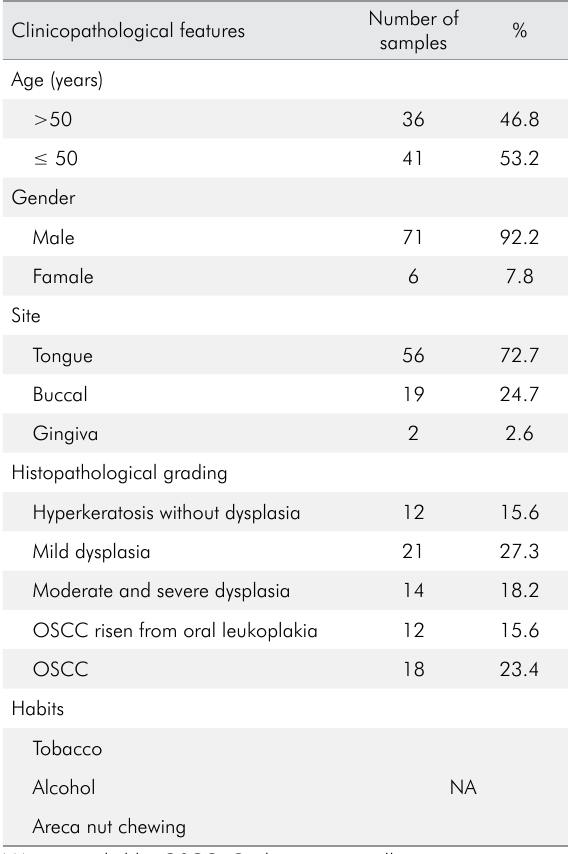
Table 1. Clinicopathological